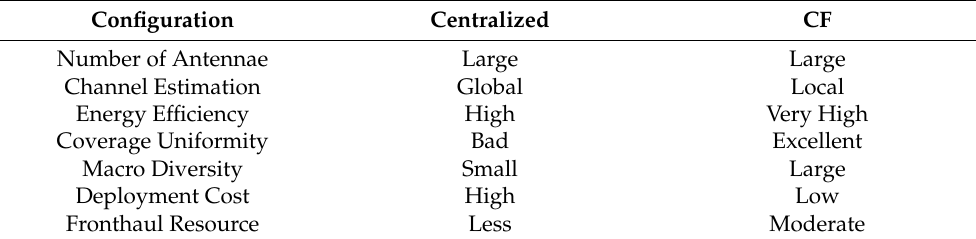
Table 2. A comparison of centralized mMIMO and CF-mMIMO networks.